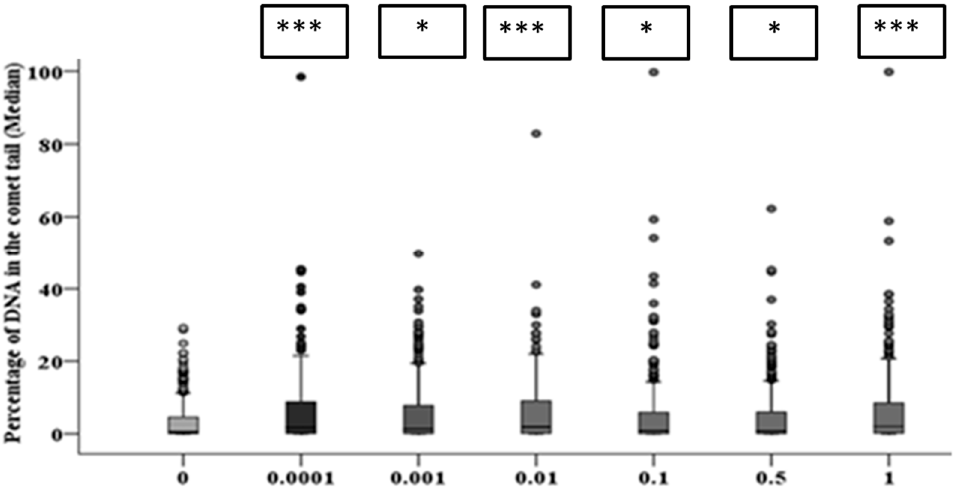
Figure 8. Intermediate responses within the progeny of alpha-particle irradiated cell populations after 10 population doublings following irradiation. Panel A shows the variation in median values as a function of dose for 1000 cells from both the two parallel but separate experiments. Panel B exhibits the DNA damage distribution of combined data from two parallel but separate experiments (* = p ≤ 0.05, *** = p ≤ 0.001).